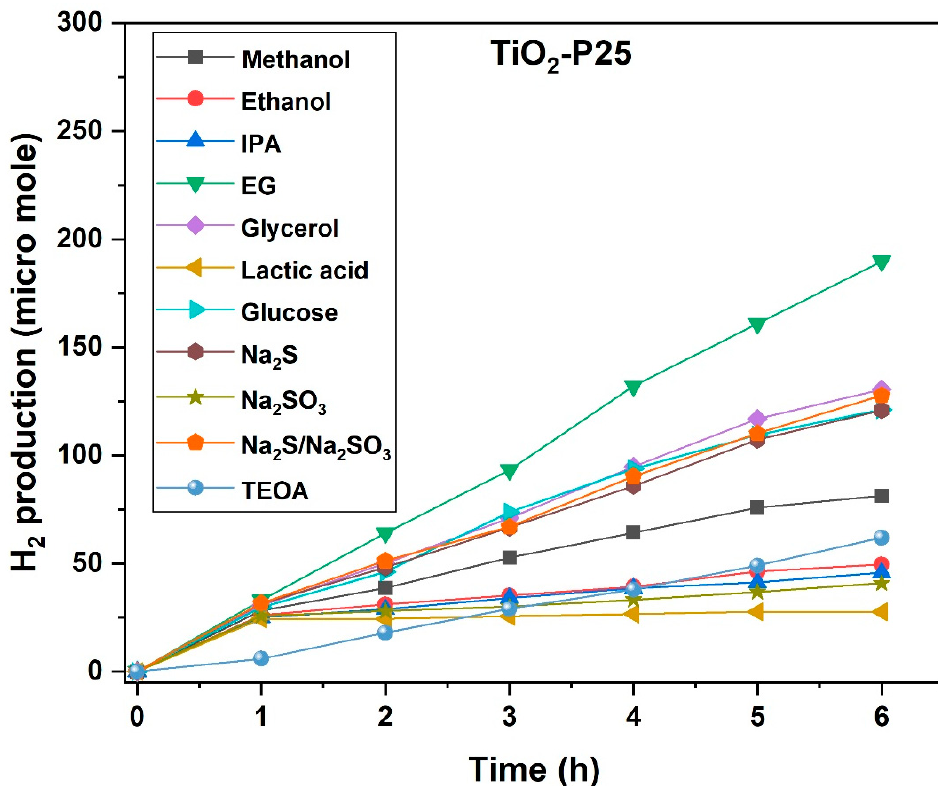
Figure 2. Photocatalytic H 2 production efficiency of TiO 2 -p25 using various sacrificial agents.